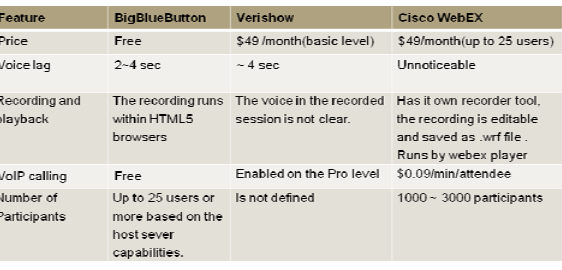
Table 4: Comparison of Web-Service